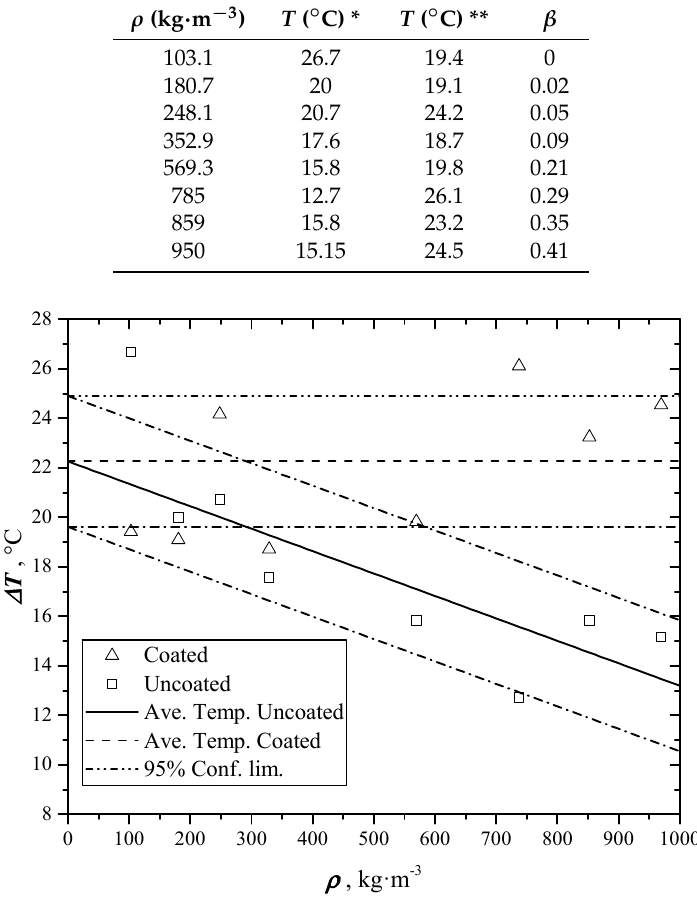
Table 4. Results of reflectance β at different densities (*Uncoated, ** Coated).